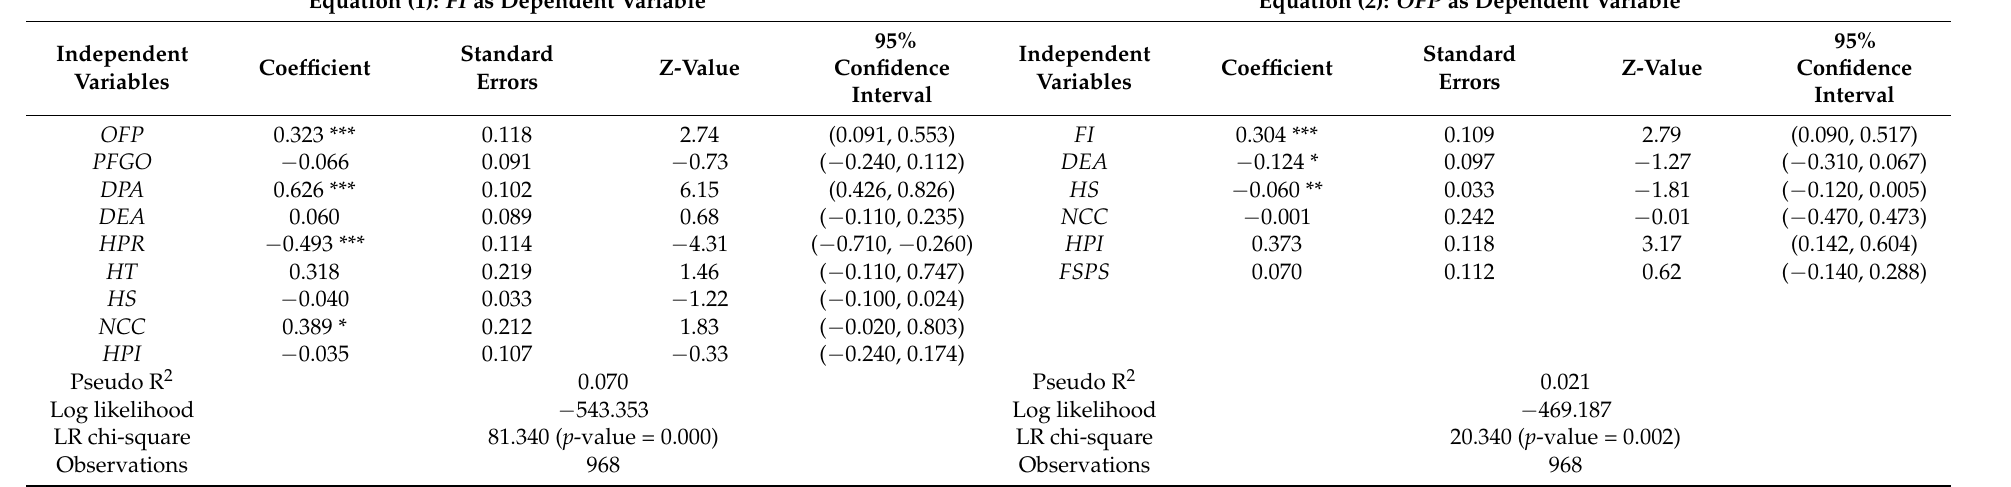
Table 6. Estimated results of simultaneous equations: model